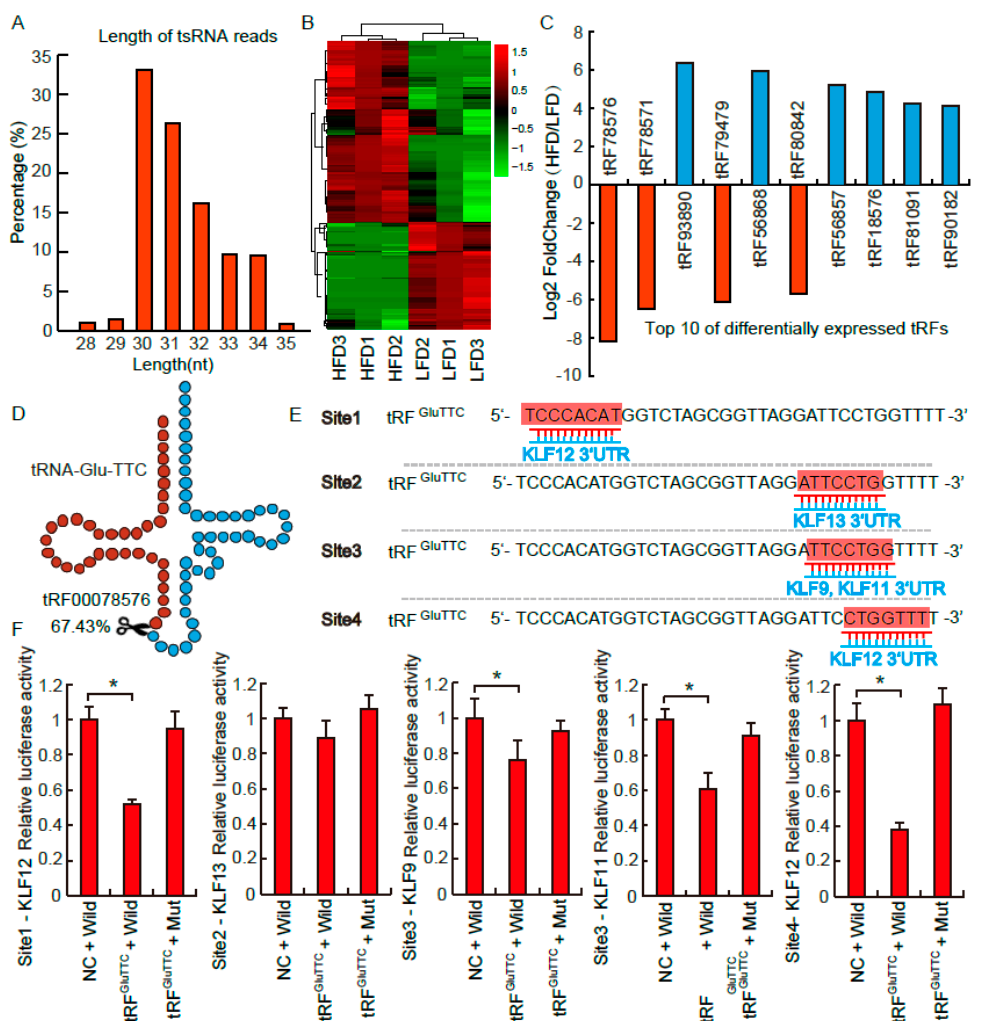
Figure 2. tRNA derived fragments (tRFs) transcriptome sequencing and target gene prediction. ( A ) The average length of identified tRFs from 6 libraries. ( B ) Heat map diagram of differentially expressed tRFs between normal and obese rats. ( C ) The list of top 10 differentially expressed tRFs between normal and obese rats. ( D ) tRF78576 cleaved from tRNA-Glu-TTC, which occupied 67.43% of fragments derived from tRNA-Glu-TTC ( E ) tRF GluTTC has complementary sequences with 3’UTR of Kruppel-like factor (KLF) 12, KLF12, KLF9, and KLF11. ( F ) The inhibitory effect of tRF GluTTC on target genes measured by luciferase assays. All data were presented as means ± standard deviation. * p < 0.05.